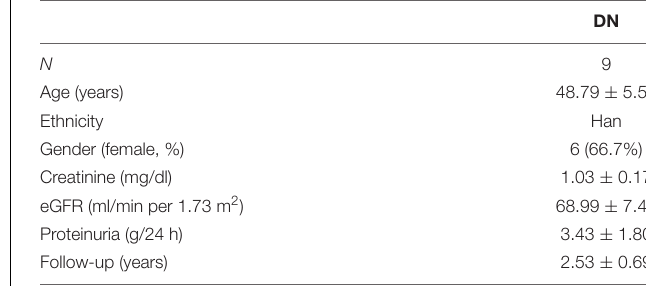
TABLE 1 | Baseline characteristics of DN